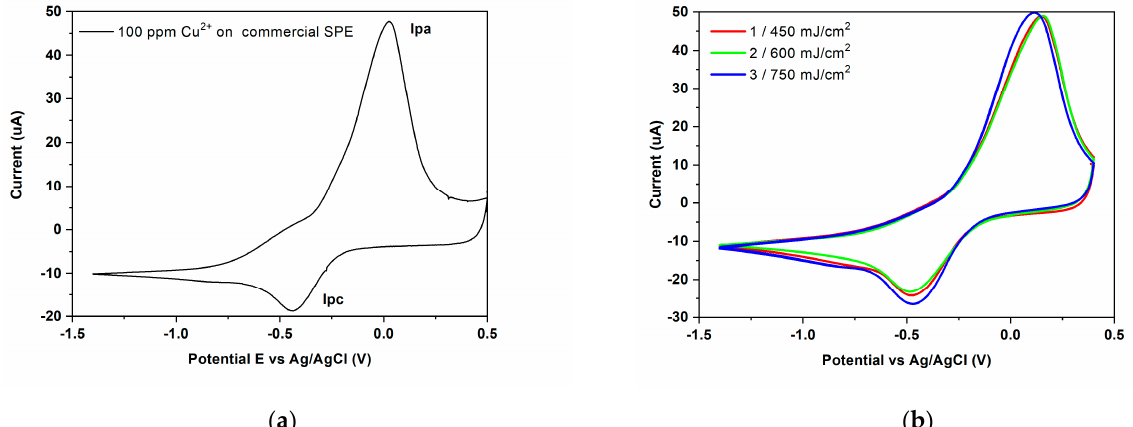
Figure 6. ( a ) Cyclic voltammogram of Cu 2+ (100 ppm) in 0.1 M acetate buffer solution (pH = 5.0) recorded on the commercial SPE based PEDOT ( b ) Cyclic voltammogram of Cu 2+ (100 ppm) in 0.1 M acetate buffer solution (pH = 5.0) recorded on PEDOT:PSS: GO sensors fabricated at different laser fluences: 1 = 450 mJ/cm 2 ; 2 = 600 mJ/cm 2 ; 3 = 750 mJ/cm 2 .